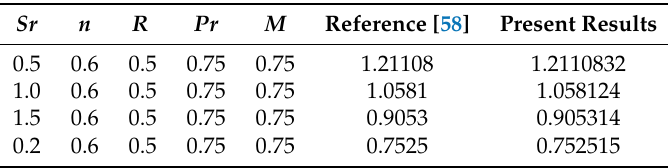
Table 3. Comparison of the Sh x results, for Du = λ =